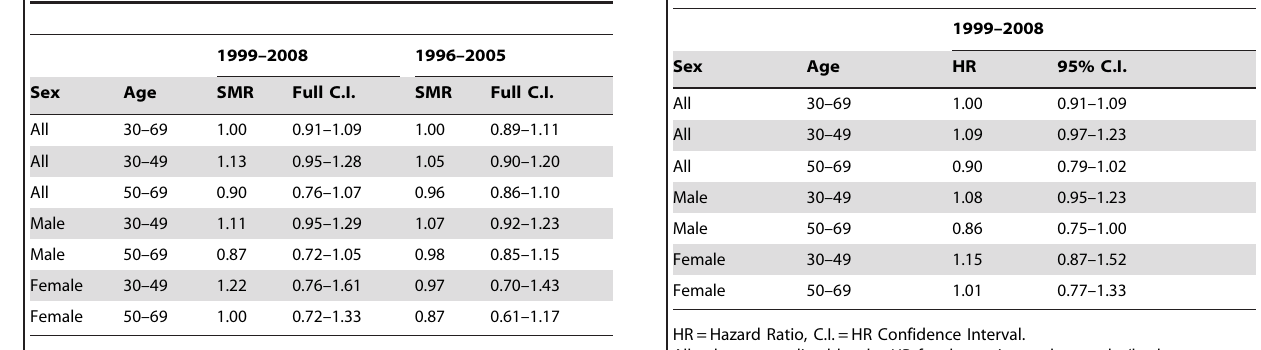
10-year observation